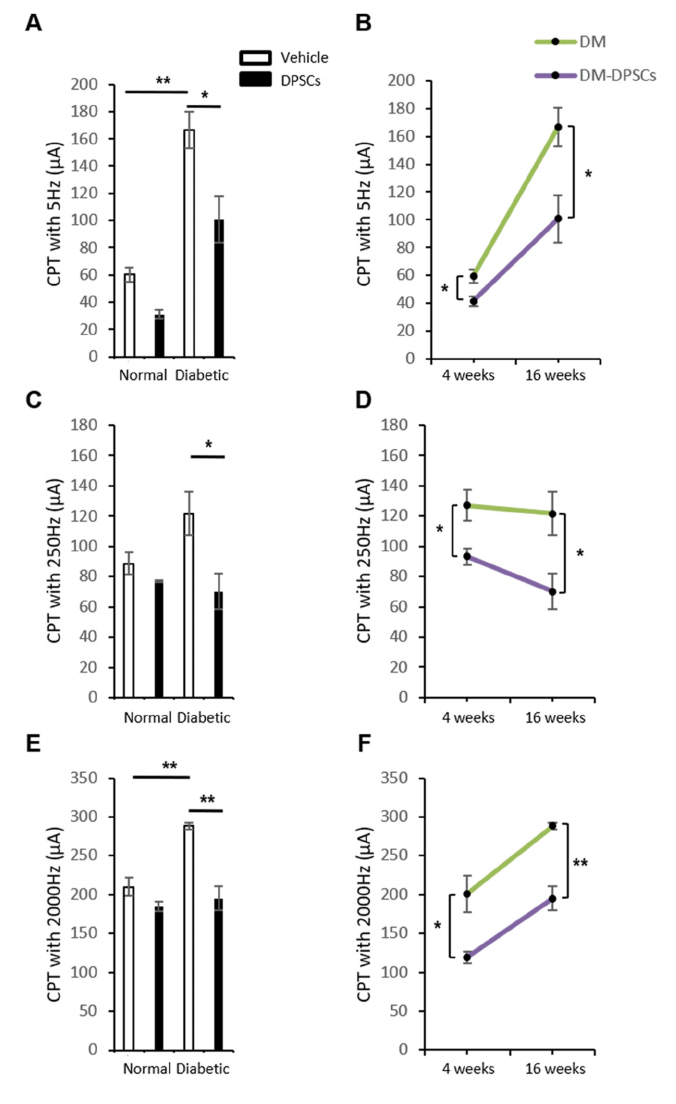
Figure 6. Sensory nerve functions. Measurements of current perception thresholds (CPTs) at 5, 250, and 2000 Hz, which demonstrated the thresholds of the C fiber, A δ fiber, and A β fiber of peripheral nerves. ( A ) CPTs at 5 Hz at 16 weeks after hDPSC transplantation. ( B ) CPTs at 5 Hz at 4 and 16 weeks after hDPSC transplantation in diabetic mice. ( C ) CPTs at 250 Hz at 16 weeks after hDPSC transplantation. ( D ) CPTs at 250 Hz at 4 and 16 weeks after hDPSC transplantation in diabetic mice. ( E ) CPTs at 2000 Hz at 16 weeks after hDPSC transplantation. ( F ) CPTs at 2000 Hz at 4 and 16 weeks after hDPSC transplantation in diabetic mice. The results are expressed as the mean ± SEM ( n = 4). * p < 0.05, ** p < 0.01. DM: diabetes mellitus .